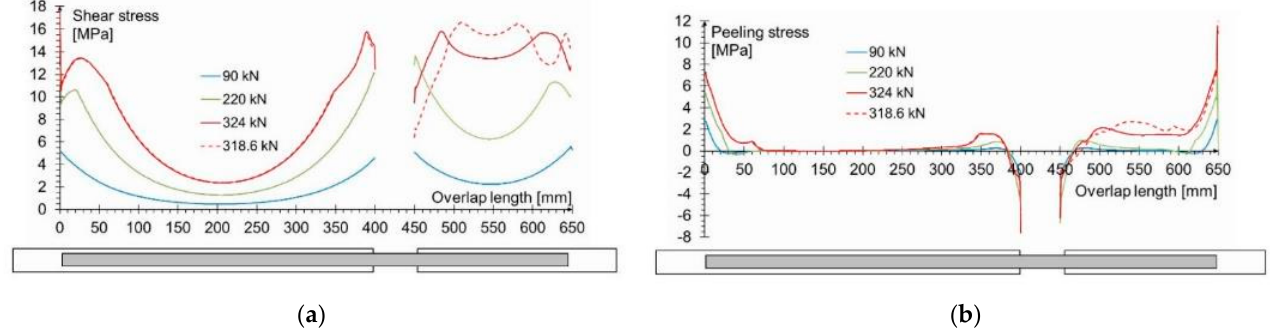
Figure 19. Stresses in the adhesive layer taken from numerical model: ( a ) shear stresses ( b ) tensile (peeling) stresses.